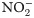
Comparison of measured and simulated data assuming stochastic initiation of nirS transcription.Each panel compares the measured NO2− depletion (sub-panel) and N2 accumulation (main panel; n = 3–4) with simulations. The simulations are carried out with an optimised specific-probability of nirS transcriptional initiation (average rNi = 0.004 h-1, Eqs 4, 5, 6 and 7), allowing 7.7–22.1% of the population to produce NirS + cNor (Eq 8) during the available time-window (= 19.5–47.3 h).